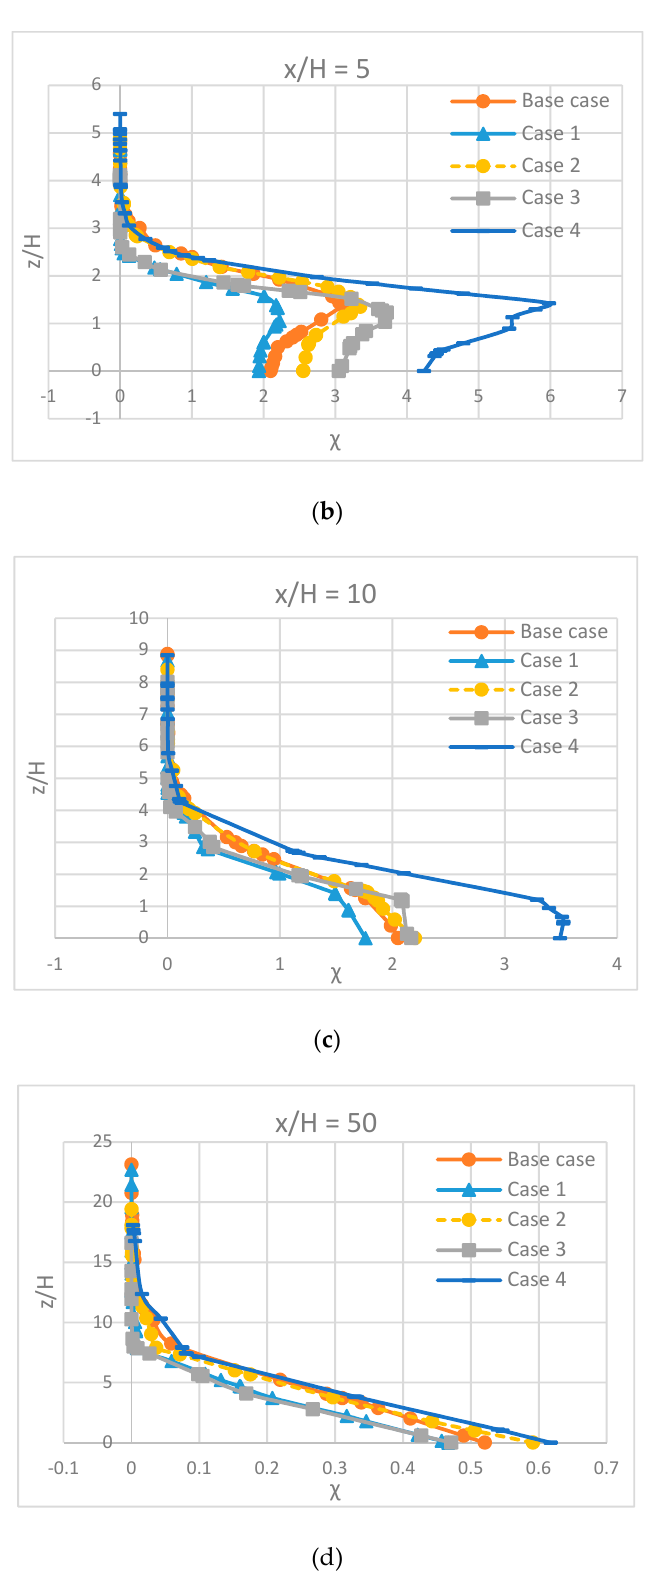
Figure 23. Vertical distribution of CO normalized concentration at different locations (H = 6 m). ( a ) x/H = 0: on the highway; ( b )( c ) x/H = 5, 10: near the highway; ( d ) x/H = 50: far downstream.